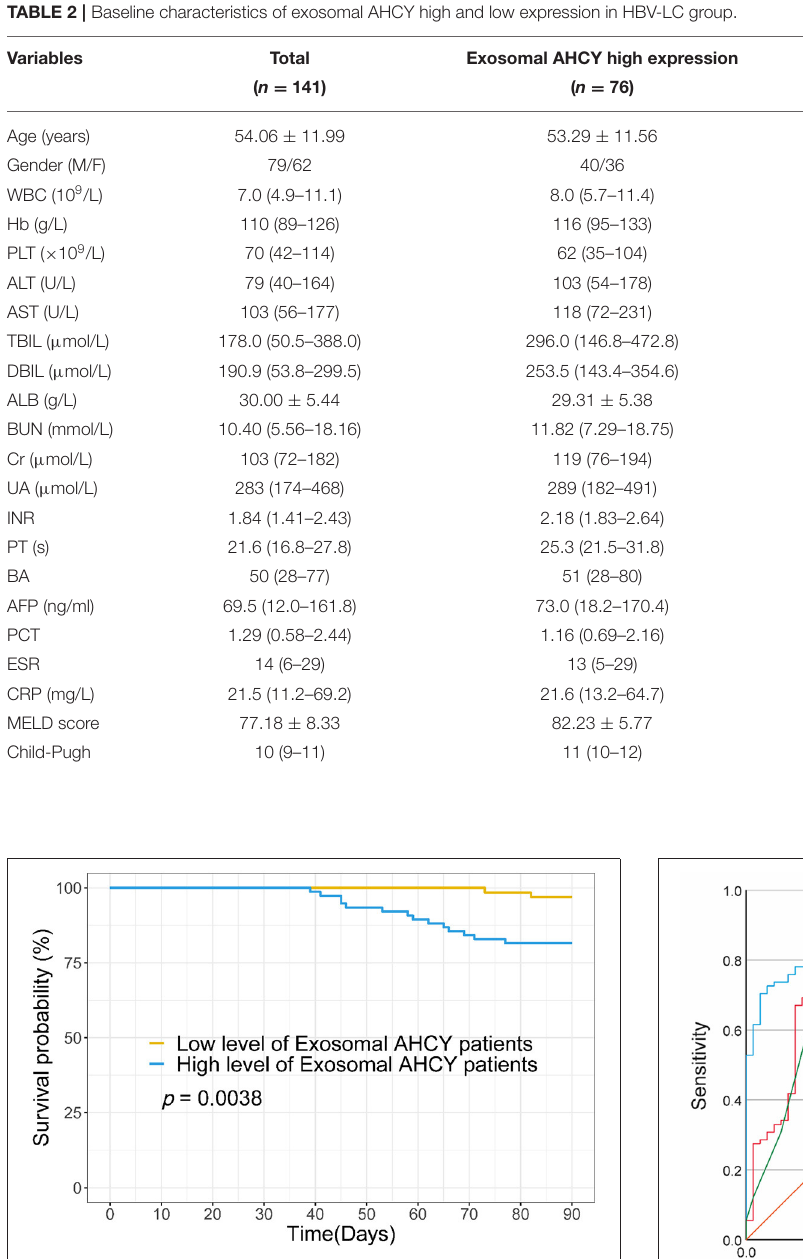
FIGURE 4 | Survival curve analysis the relationship between serum exosomal AHCY level and survival time for HBV-LC patients. liver, as well as the exact mechanism of beetroot protection, include decreased Hcy and SAH levels or increased S-adenosine methionine concentrations. Stender et al. (27) found that AHCY deficiency is associated with early-onset HCC. Vazquez et al. (20) screened novel serum markers in a mouse model of liver injury and demonstrated that AHCY expression significantly increased with the increase in the degree of liver injury. However, there are no studies of the role of exosomal AHCY in HBV-LC.